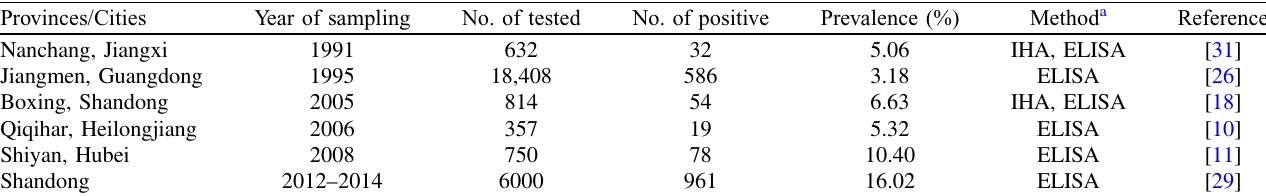
Table 1. Prevalence of T. gondii infection in primary school children in the PR China.